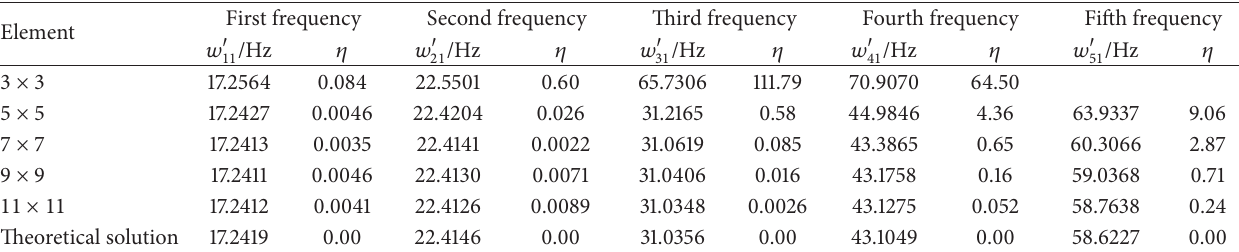
Table 1: First five natural frequencies and their relative errors of manifold calculation. First frequency Element